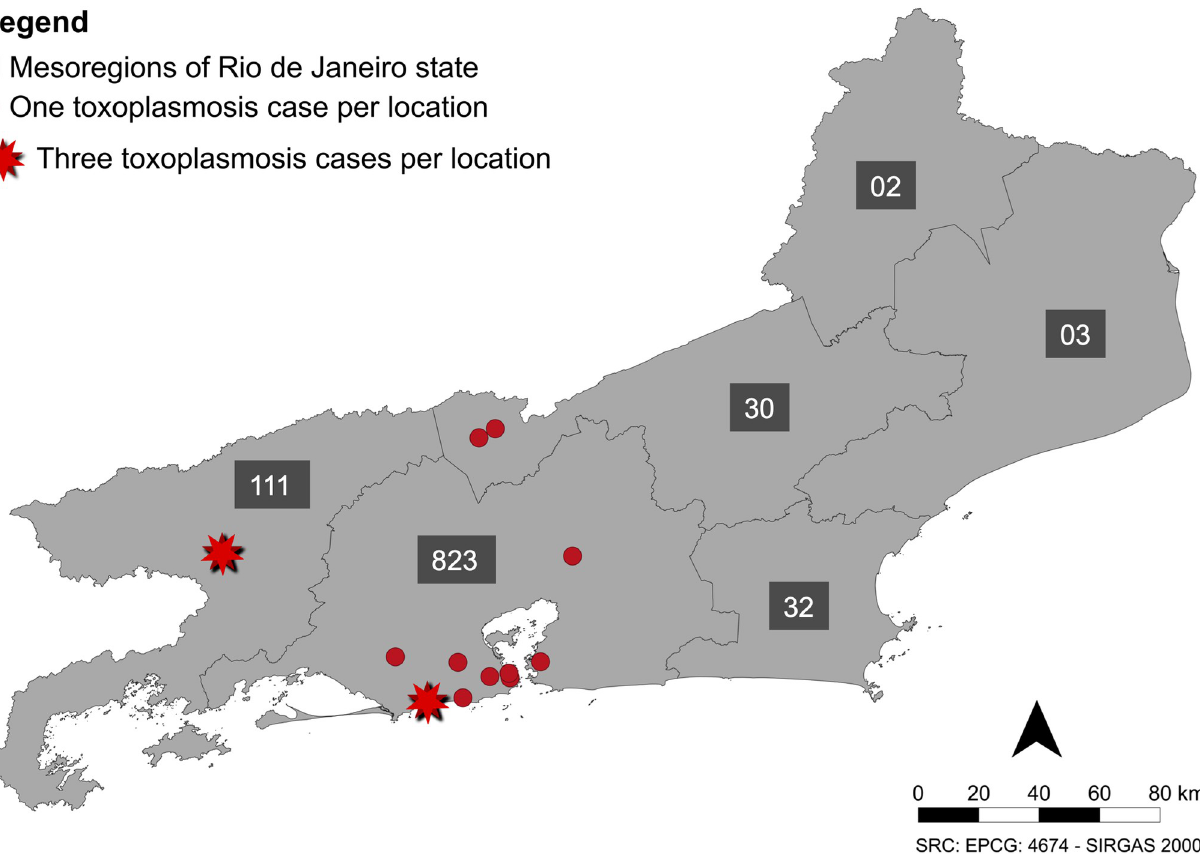
Fig 1. Distribution of toxoplasmosis cases in free-ranging marmosets from Rio de Janeiro state from January 2017 to July 2019. Map from Rio de Janeiro mesoregions (IBGE 2021) with total number of animals with by each mesoregion (grey box). SRC: EPCG 4674 –SIRGAS 2000 (QGIS Version